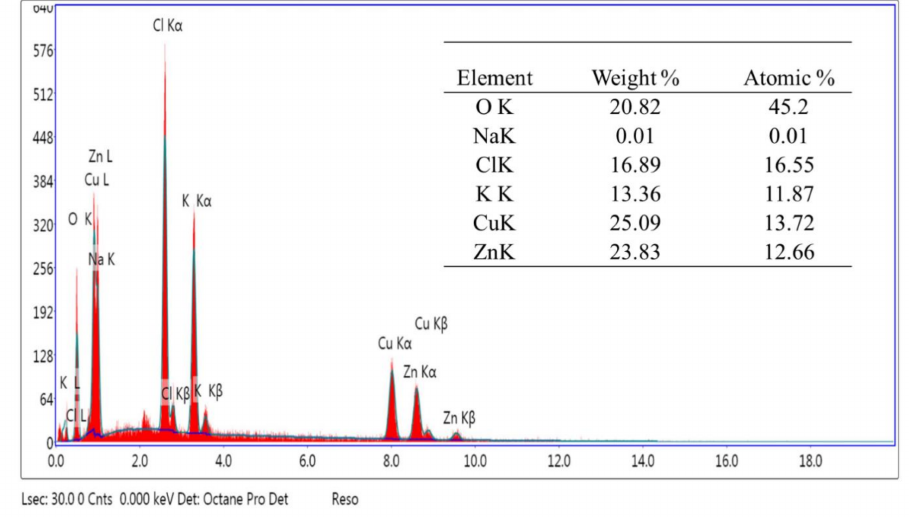
Figure 6. EDEX analysis of 1C1Z greenly prepared via the hydrothermal route (pH = 10, T = 250 ◦ C, t = 2.5 h) and calcination for 2 h at 300 ◦